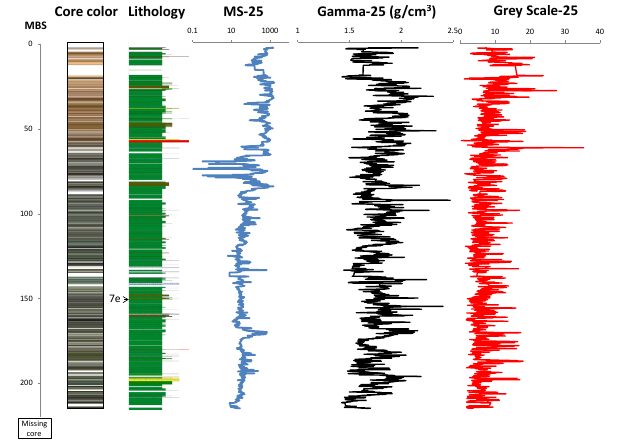
Figure 8. Summary stratigraphy of core HSPDP-BTB13-1A, from the Tugen Hills drilling area, central Kenyan Rift Valley, based on initial core description results. Columns from left to right: core color stratigraphy; lithologic log; see Fig. 5 for the key to litholo- gies used in all cores illustrated; composite of magnetic susceptibil- ity (MS) log data (25-point running mean smooth) from LacCore Geotek © XYZ point sensor data; composite of induced gamma density log data (25-point running mean smooth, spurious values <1.0gmcm − 3 removed; n.b.: lower threshold used than for NA cores because of abundant dry and porous diatomites); composite of spectrophotometric grey-scale log data (25-point running mean smooth). All other data collection, instrumentation, and parameters as in Fig. 5.